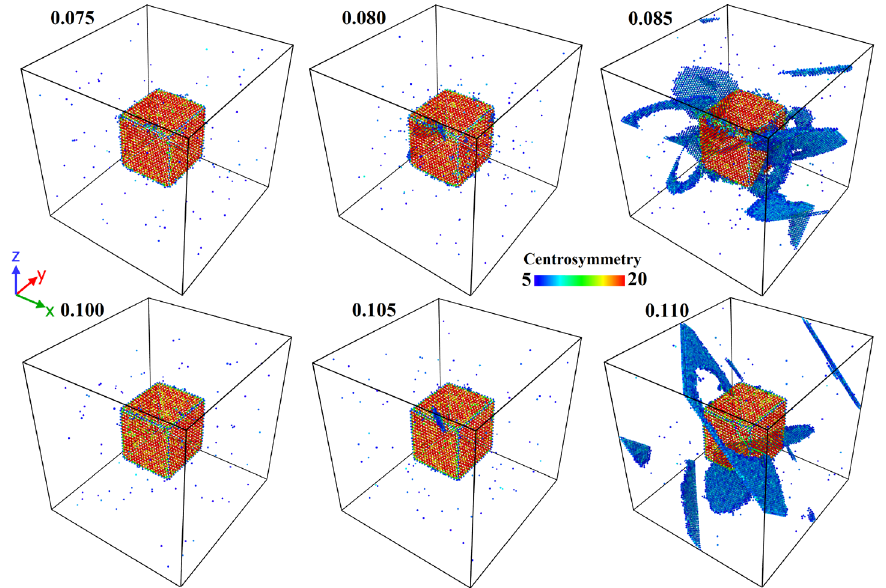
Figure 4. Plasticity incipience (nucleation of dislocations) in aluminum single crystals with cubic nanopores equivalent to 8 nm. Top and bottom panels represent two different deformation paths; the current values of the engineering strain are shown near the atomic configurations. The color scheme is the same as in Figure 2.